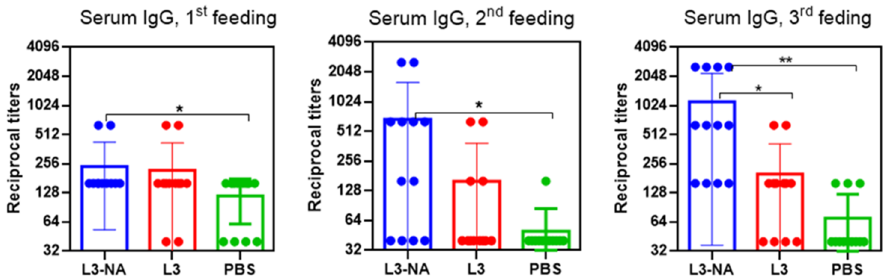
Figure 6. Immunogenicity in CBA mice estimated as serum IgG levels to A/Leningrad/134/17/57 (H2N2) influenza virus ( n = 10 − 12). Dots represent individual antibody titers in mice. * p < 0.05, ** p < 0.01.